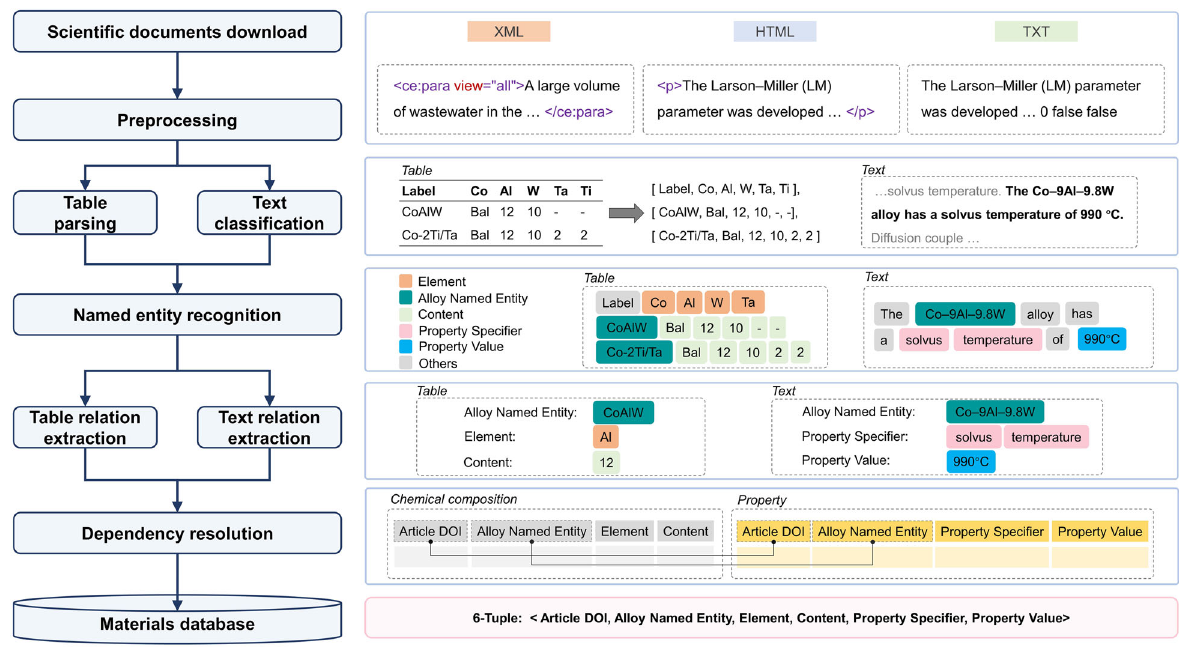
Fig. 1 Schematic work fl ow of the automated text mining pipeline. The work fl ow involves several stages of scienti fi c documents download, preprocessing, table parsing, text classi fi cation, named entity recognition, table and text relation extraction, and interdependency resolution. A corpus of scienti fi c articles is scraped and the irrelevant information in raw corpus is then fi ltered during preprocessing. According to the table parsing and text classi fi cation, the tables and sentences with target information are determined for named entity recognition and relation extraction. The alloy named entity, property speci fi er and property value are recognized by named entity recognition, and relation extraction of text and table gives the speci fi c tuple relations. Interdependency resolution resolves the linkage to chemical composition and property data fragments for one speci fi c material, and fi nally outputs a complete record into materials